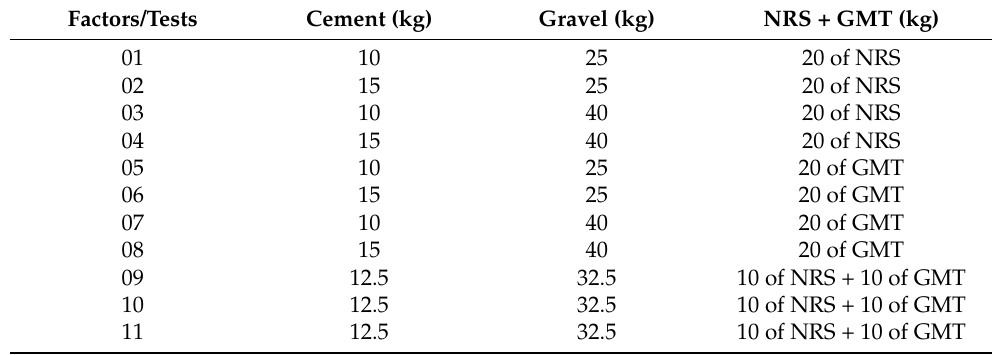
Table 4. Matrix of